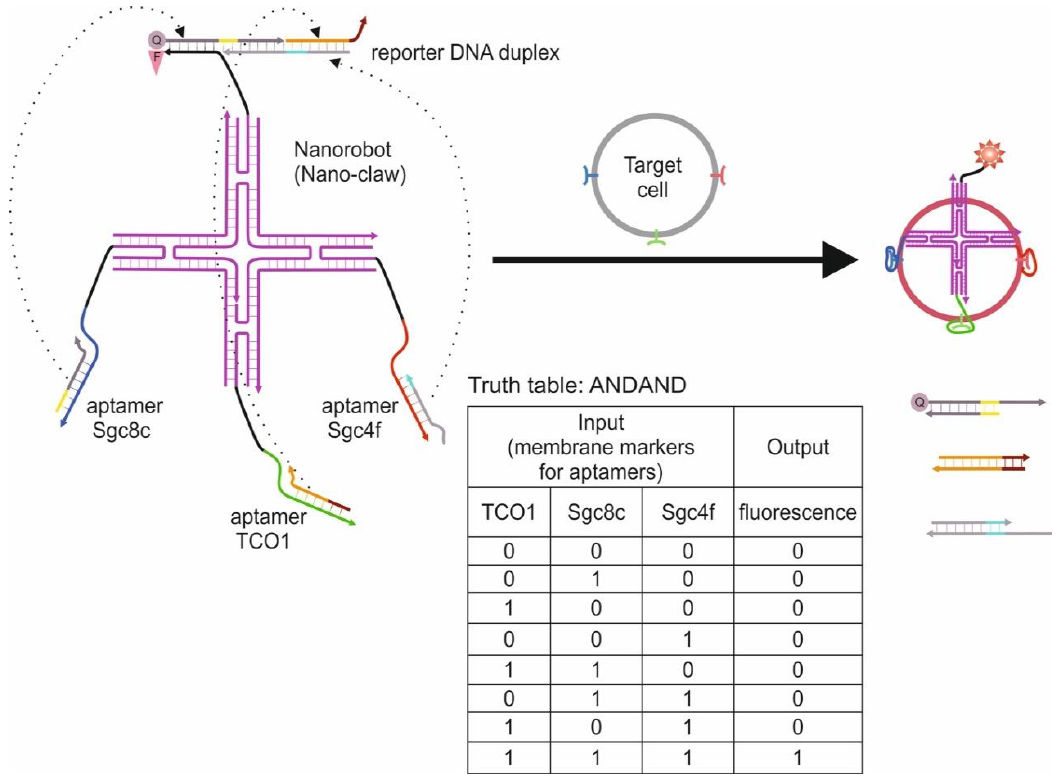
Figure 17. Logic gate i1ANDi2ANDi3. F = fluorescent label, Q = quencher label. Adapted from